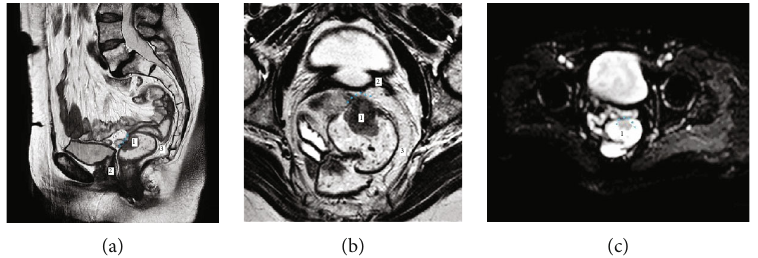
Figure 1: Radiologic data from a high-resolution pelvic MRI. Tumor of the lower rectum (1) situated on the anterior wall was observed on sagittal (a) and axial T2-weighted scans (b) with signs of mesorectal invasion (blue arrowheads) ranging up to 3mm and no radiologic features of lymph node metastases (3). Vaginal stump and rectovaginal sept (2) had a signi fi cantly low intensity MR signal due to their fi brotic transformation. On a series of di ff usion-weighted images (c), a signi fi cant delay of di ff usion together with intense signaling on high b-factors was observed at the level of a tumor (blue